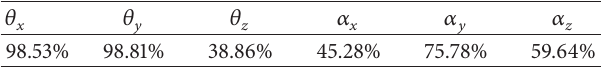
Table 4: Improvement percentage of 𝐽 V values for position and acceleration data compared with their uncontrolled